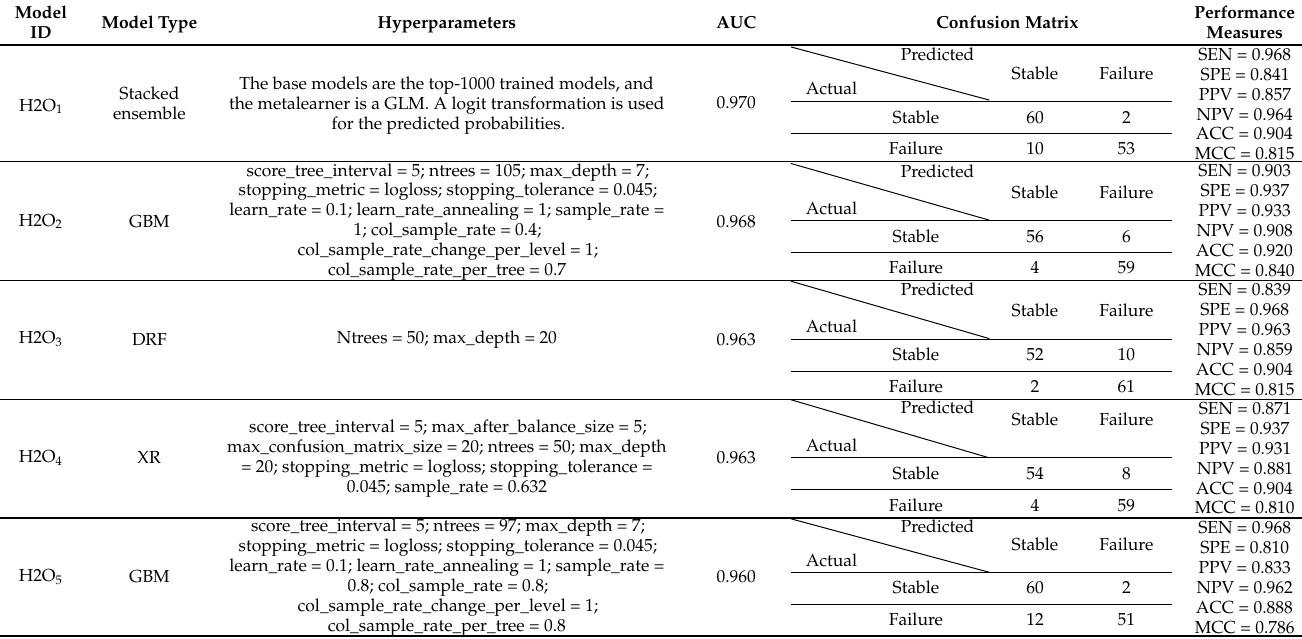
Table 5. Comparison of the performance of the selected top-five models from AutoML in slope stability assessments of circular mode failure based on the selected test